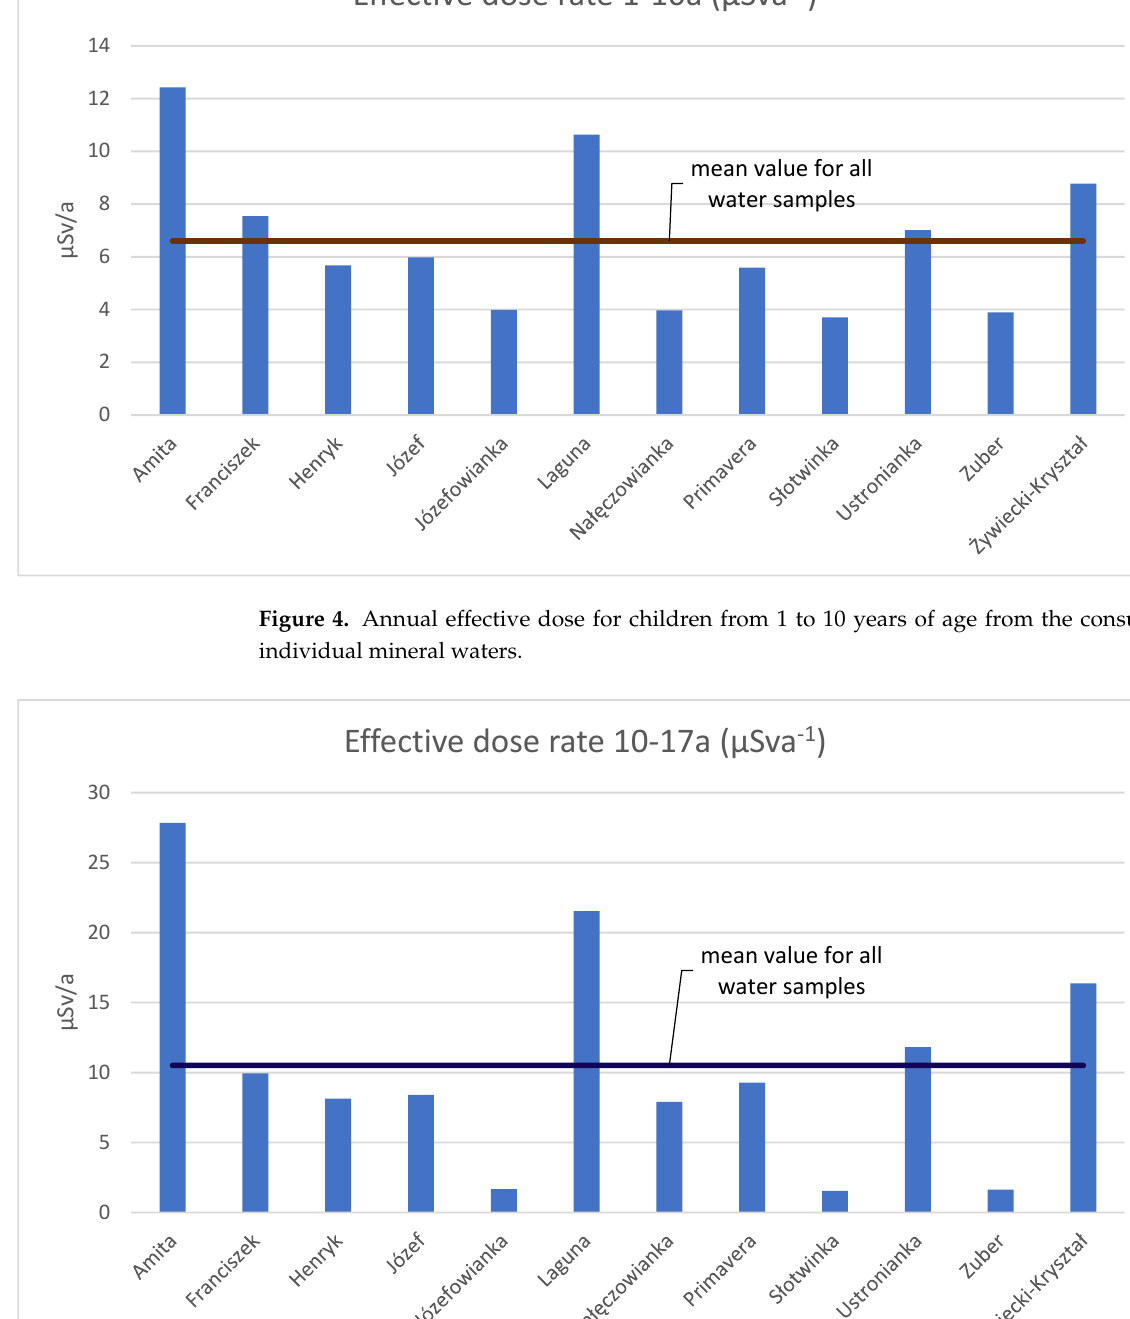
Figure 5. Annual effective dose for adolescents from 10 to 17 years of age from the consumption of individual mineral waters.